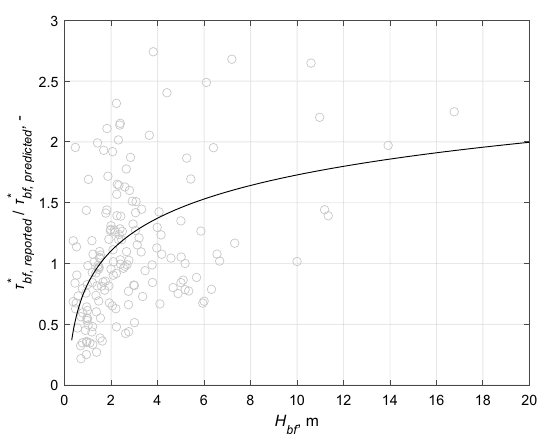
H bf in the τ ∗ bf reported /τ ∗ bf predicted data set. The (cid:30) (cid:31) as predicted (cid:31) (cid:30)